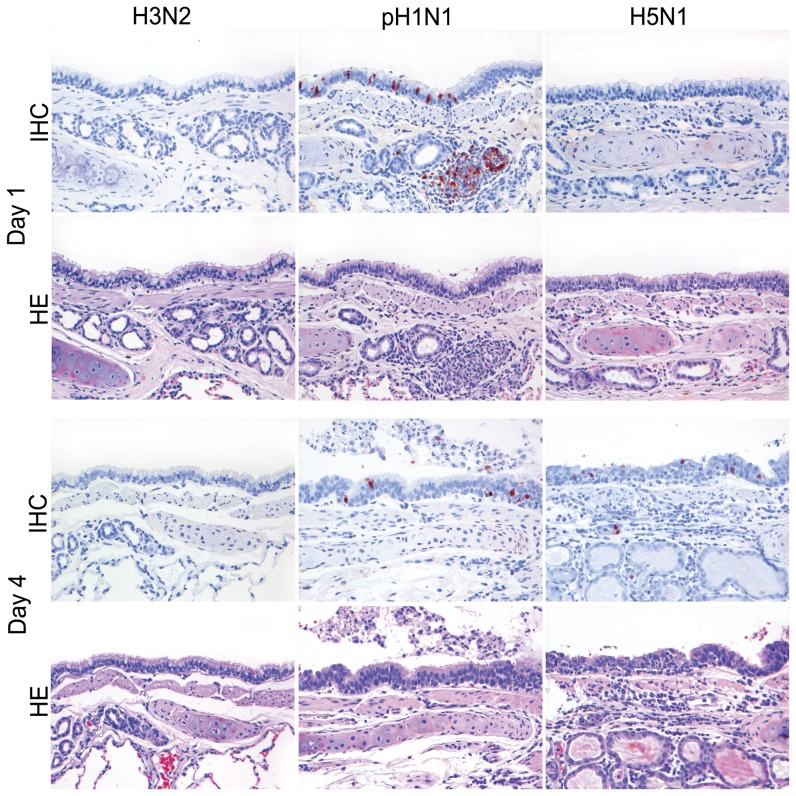
Antigen expression and histopathology of bronchial epithelium of ferrets inoculated with different influenza viruses.There is moderate antigen expression with associated lesions characterized by bronchitis in bronchial and glandular epithelium of ferrets inoculated with pH1N1 on 1 and 4 dpi, and for H5N1 only on 4 dpi. There were no antigen expression and no lesions for H3N2. HE and immunoperoxidase counterstained with hematoxylin, 200×.